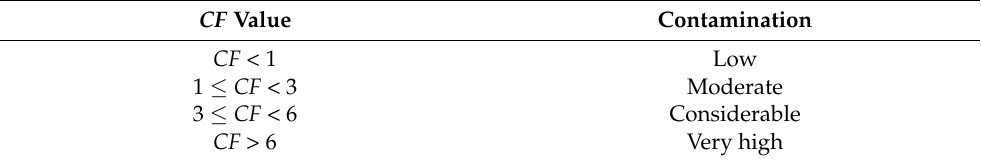
Table 3. Contamination level of sediment according to the CF value [41].